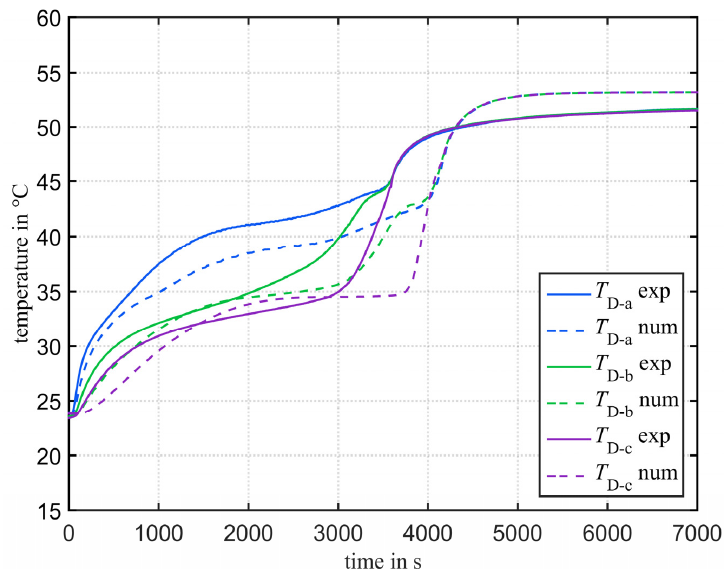
Figure 3. Comparison of the height of the solid PCM for the experimental [31] and numerical results during charging (blue indicates solid, red indicates liquid, and yellow as well as green indicate the mushy region). In order to increase the visibility of the numerical results, they were stretched in the radial direction.